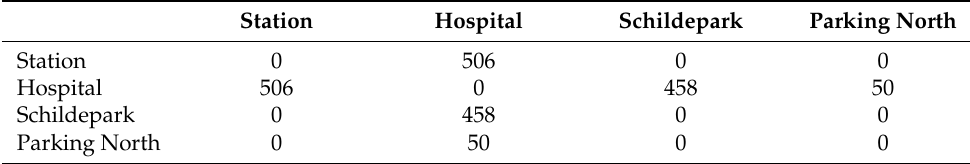
Table 1. ODM with complete travel demand of 24